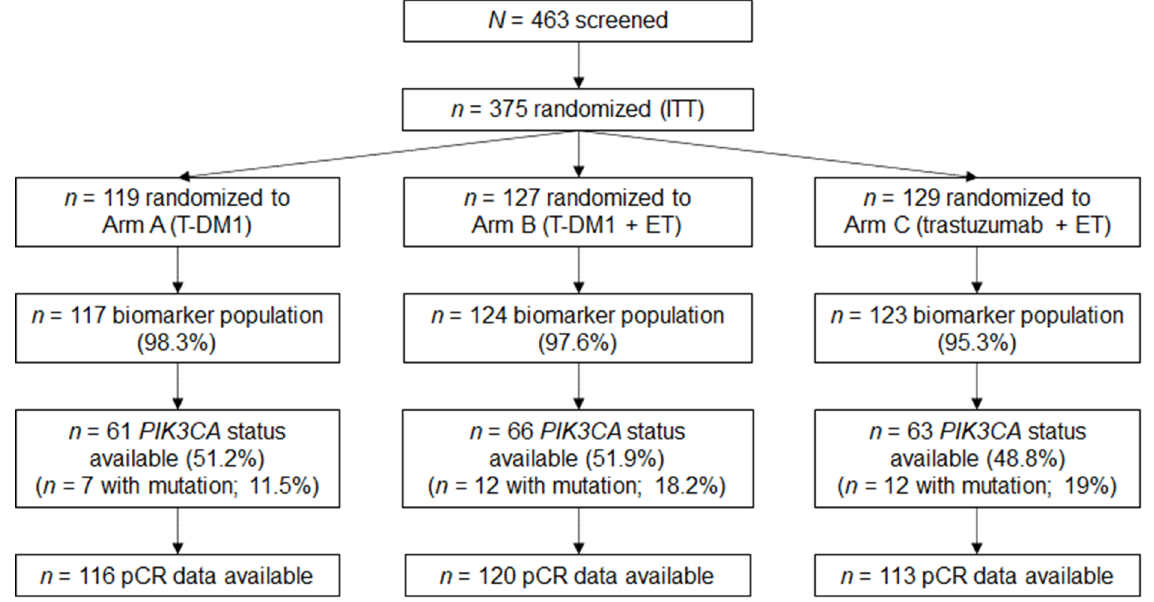
Figure 1. Patient disposition. ET, endocrine therapy; ITT, intent-to-treat; pCR, pathological complete response; T-DM1, ado-trastuzumab emtansine.